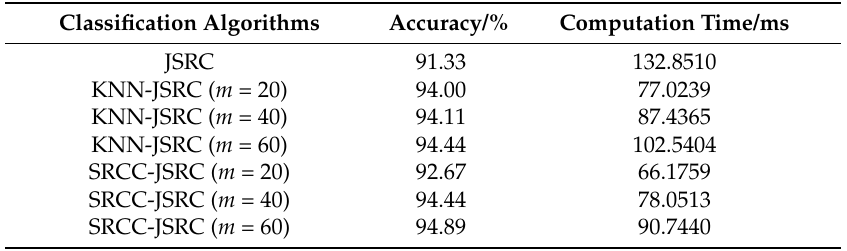
Table 2. Comparative results from the different JSRC-based gait-classification